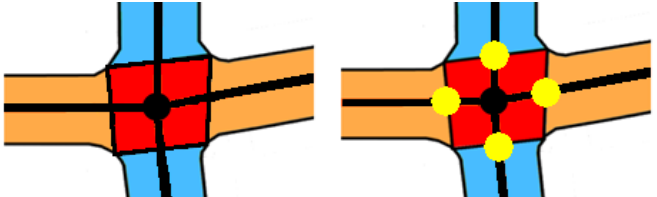
Figure 6. Potential inconsistency between linear and areal street representations ( left ) and proposed solution ( right ).